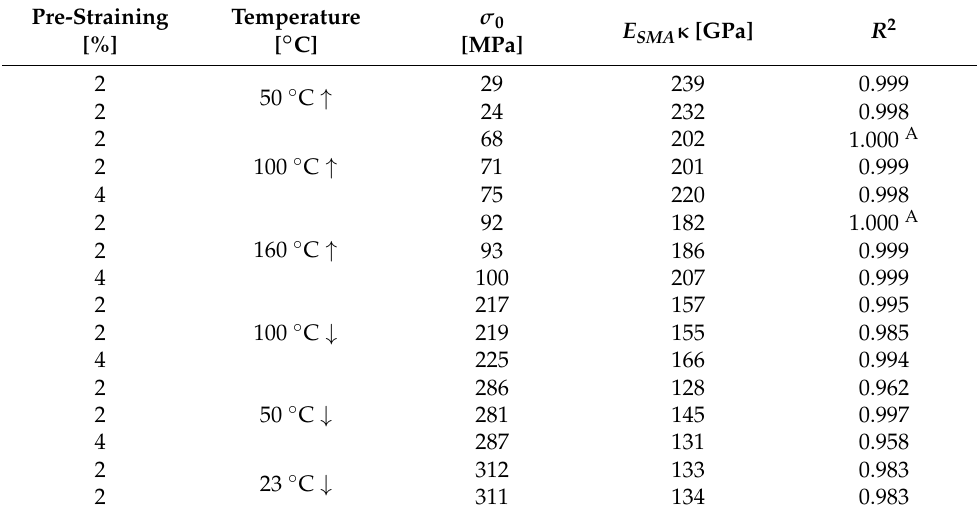
Figure 11a comprises the ∆ σ vs. ∆ ε ( ∆ σ = σ − σ 0 ; ∆ ε = ε − ε 0 ) at the beginning